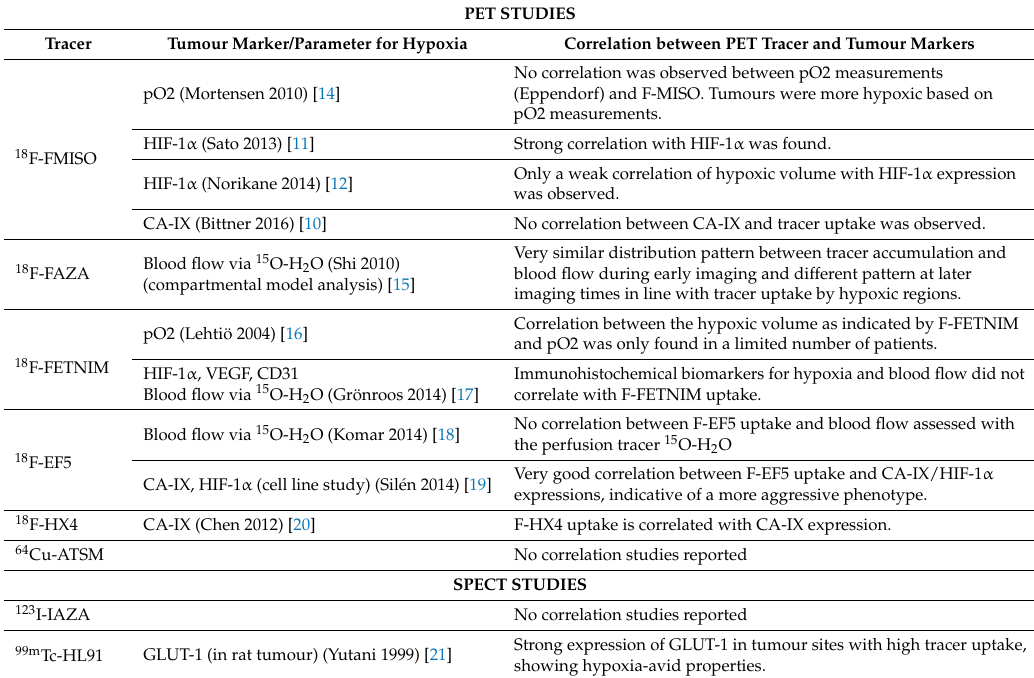
Table 2. Correlation between PET/SPECT tracers and hypoxic tumour